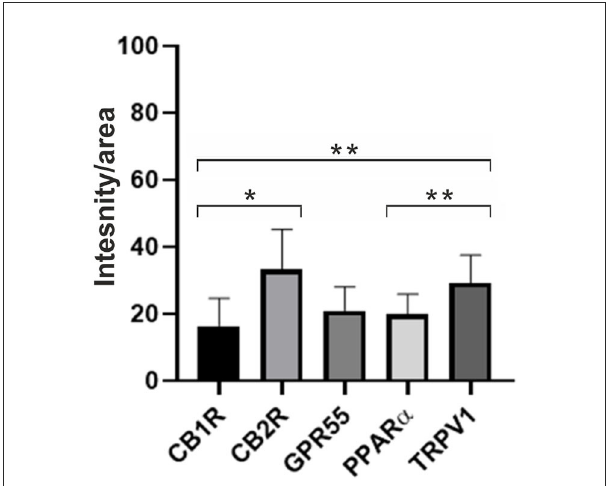
FIGURE9 Quantification of the intensity of the expression of CB1R, CB2R, GPR55, PPAR α , and TRPV1 in the synovial membrane of metacarpophalangeal joints of 12 horses. Data are represented as Mean ± SD and were analyzed using One-way ANOVA multiple comparisons test. * P < 0.05 and ** P < 0.01.